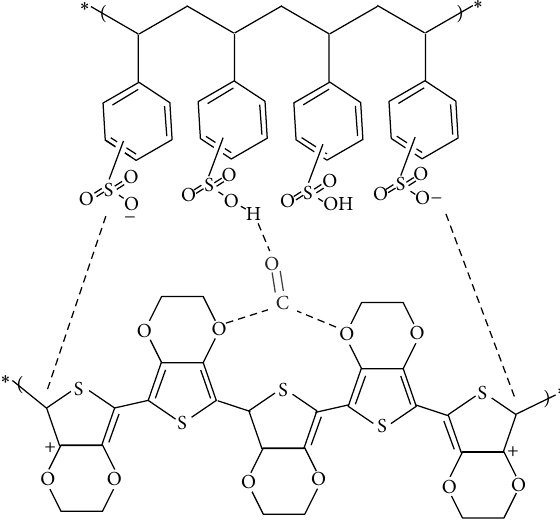
Figure 7: Schematic illustration of the sensing mechanism. ∗ represents the degree of